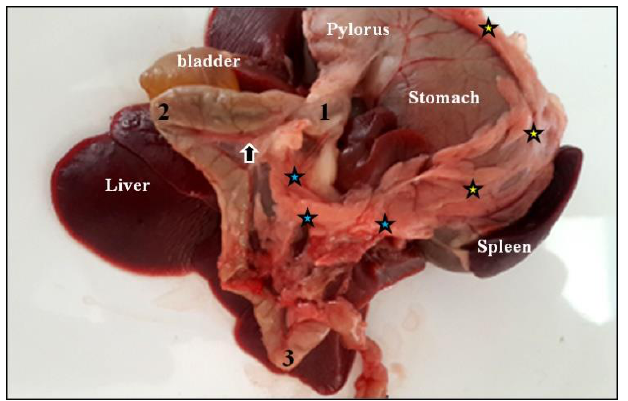
Figure 3. Dissected out pancreatic lobes with adjacent organs. It showed body (blue